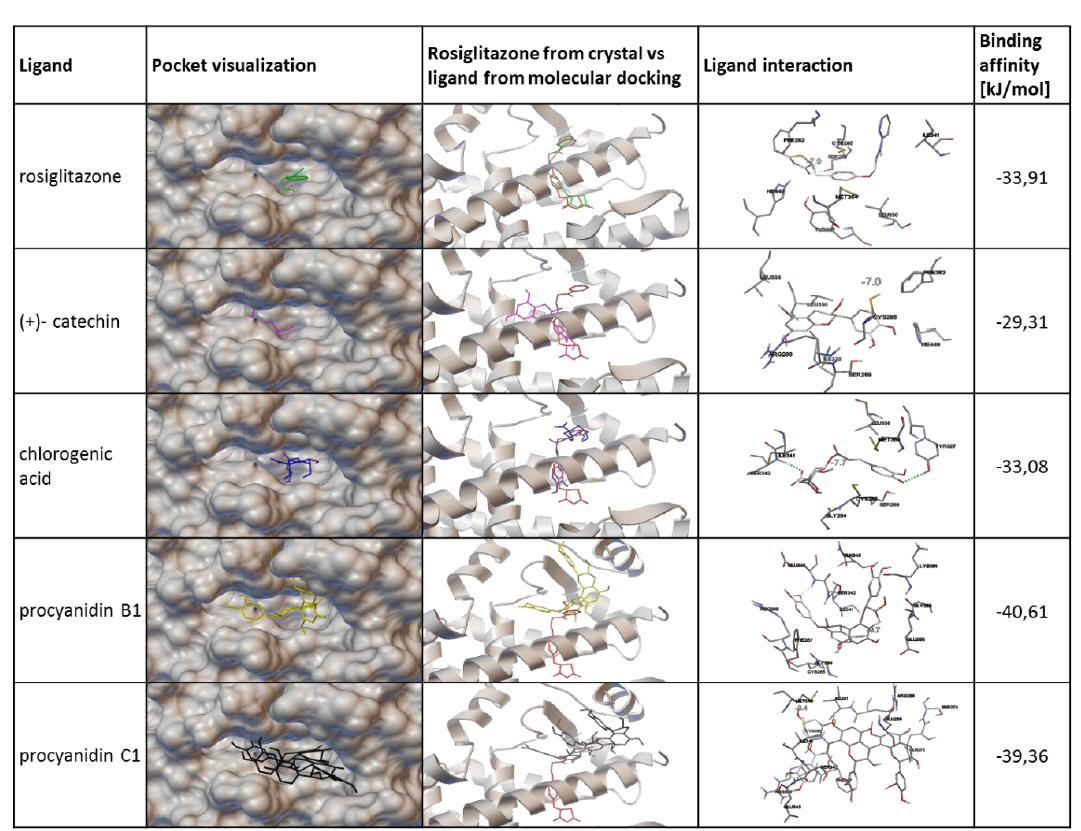
Figure 13. Interaction of tested phenolic compounds with PPARγ receptor verified with molecular docking. The active site of the PPARγ receptor is located behind the E3 helix, where a small cavity is formed. An agonist of PPARy, rosiglitazone, enters the receptor-active site and locates deep inside the binding pocket. Molecular models of rosiglitazone, (+)- catechin, chlorogenic acid, procyanidin B1 and procyanidin C1 are shown on the entrance of the active pocket site. Orientation of models are presented in comparison to the crystal model of rosiglitazone. Interactions of the models with corresponding binding affinities are presented in the two last columns. Molecular docking was performed with AutoDock Vina.